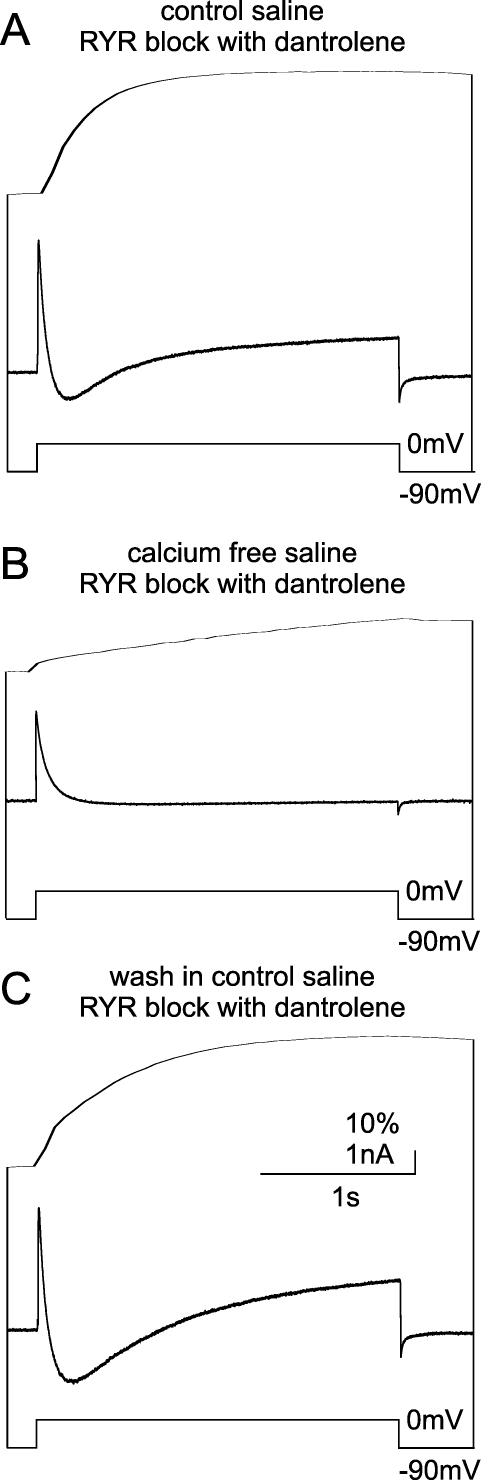
Voltage-Induced Intracellular Calcium Signals That Occur in the Absence of Extracellular Calcium Do Not Depend on RYRs(A) In dantrolene-loaded, acutely isolated DUM neurons in TEA- and TTX-containing saline, a voltage step from −90 mV holding to 0 mV test potential causes a calcium inward and a calcium-activated potassium outward current accompanied by an intracellular calcium signal.(B) After 3 min in calcium-free saline, a slow elevation in intracellular calcium occurs in response to the same voltage step as in (A), although RYRs are blocked by intracellular application of dantrolene (100 nM).(C) Switching back to calcium-containing extracellular saline restores membrane currents and intracellular calcium signals as observed in (A).